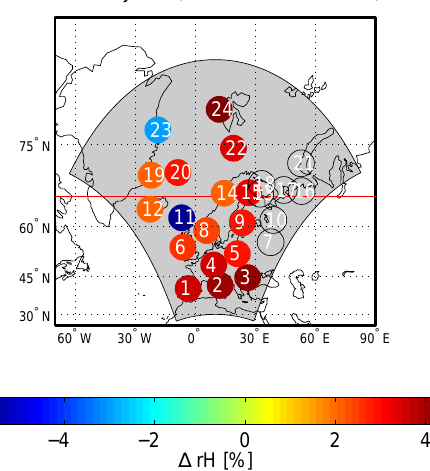
Figure 15. Mean difference of measurements and model values of relative humidity for each station when using ERA-Interim as forc- ing data. The picture is similar when using NCEP reanalysis data.